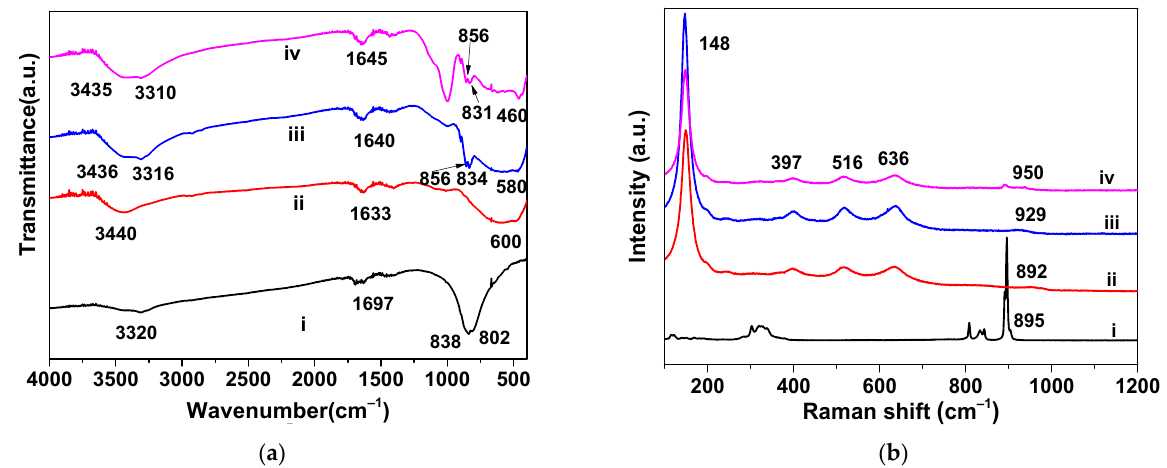
Figure 2. FT-IR spectra ( a ) and Raman spectra ( b ) of the (i) pure Na 2 MoO 4 powder, (ii) Na 2 MoO 4 – 15.4%-TiO 2 , (iii) Na 2 MoO 4 – 24.1%-TiO 2 , and (iv) Na 2 MoO 4 – 41.4%-TiO 2 samples.